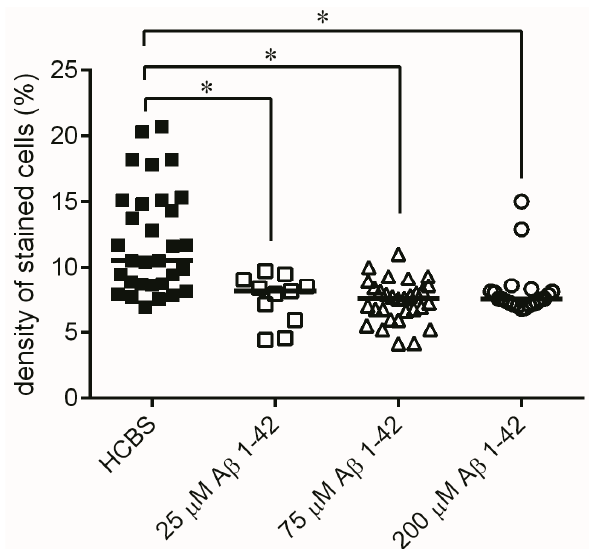
Figure 12. Cresyl violet staining of hippocampal slices after treatment with 168 h aggregated oA β assemblies using increasing aggregation concentrations (25, 75 and 200 μ M) of synthetic A β 1-42. Each dot represents the counted raw data, while horizontal bars indicate median values. Significant differences in the staining density were observed between HCBS and the 25 μ M A β 1-42 treated group ( p = 0.011), HCBS and the 75 μ M A β 1-42 treated group ( p < 0.001), as well as between HCBS and the 200 μ M A β 1-42 treated group ( p < 0.001), n = 4, 2 slices/animal; n refers to the number of animals per group. Statistical significance was determined by a nonparametric independent-samples Kruskal–Wallis test. * Differences with a p -value < 0.05 were considered significant.